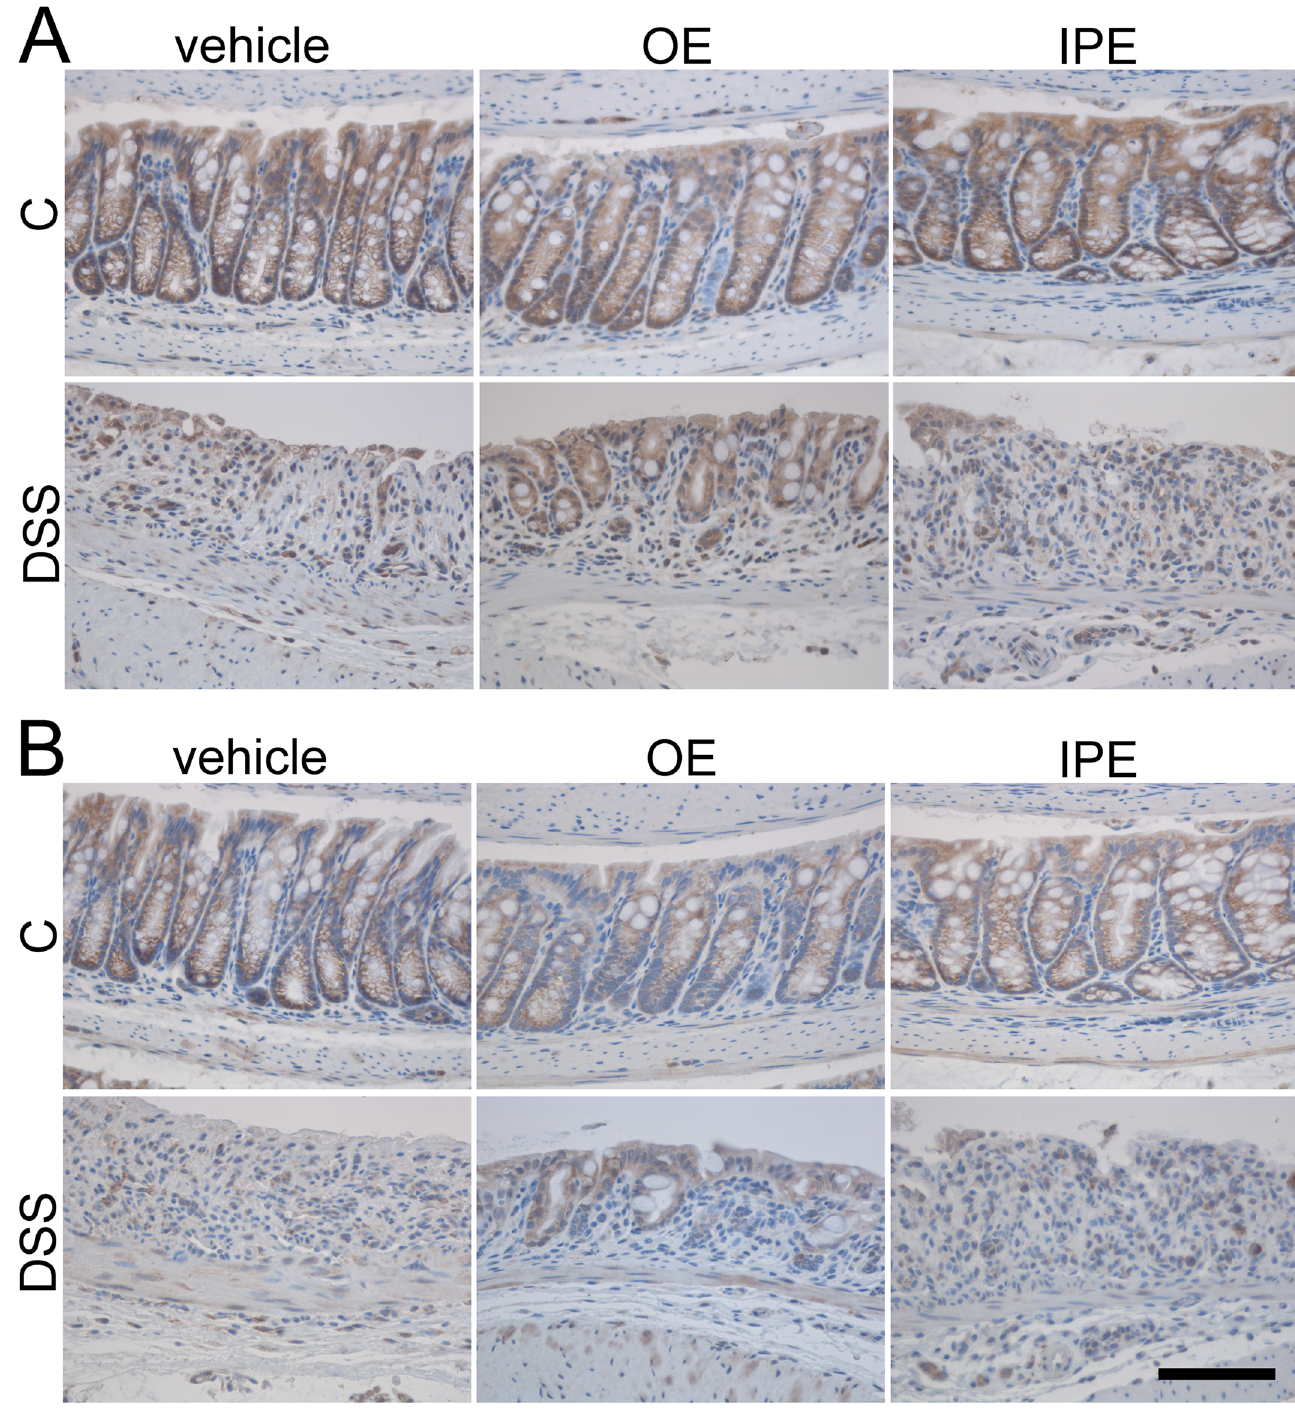
Fig 11. Effect of enoxaparin on epithelial tight junctions of colon. Immunostaining of (A) occludin and (B) claudin-4 in the distal colon of healthy and colitis mice treated with and without enoxaparin. Scale bar = 100 μ m for 400 × magnification. Control, C; untreated colitis, DSS; oral enoxaparin, OE; intraperitoneal injection of enoxaparin,